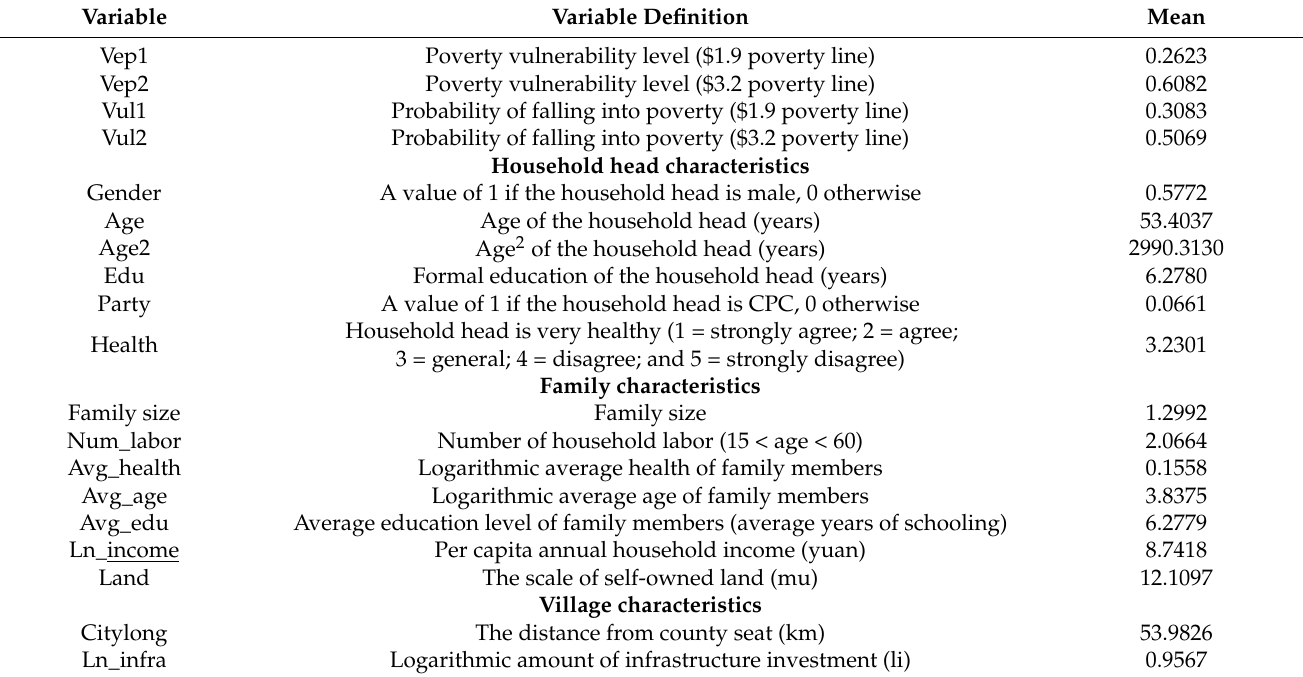
Table 2. The results of other variable definitions and descriptive